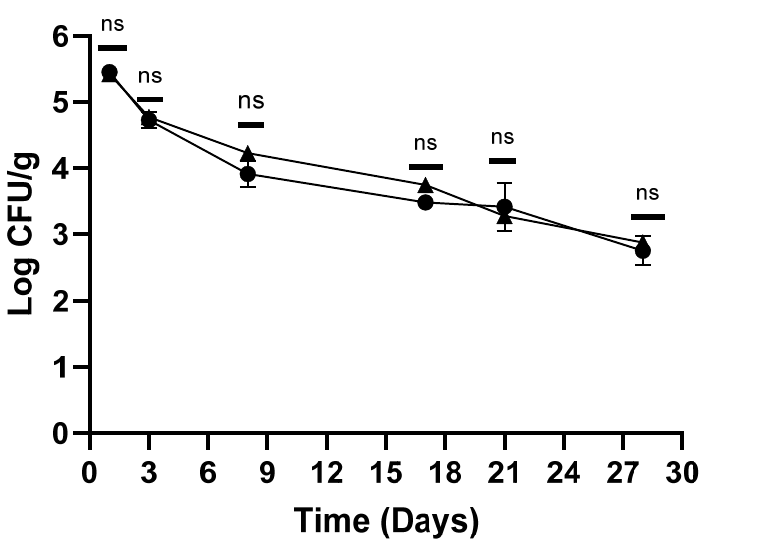
Figure 1. Trend of L. monocytogenes during the sausages production with (PELM) and without (LMC) plant extract. p -values of * < 0.05 , ** p < 0.01, *** p < 0.001 and **** p < 0.0001 were considered significant by t -test and ANOVA. ns means not significant.